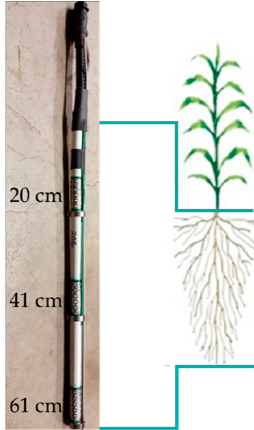
Figure 5. Node of three watermark soil moisture sensors located at depths of 20 cm, 41 cm, and 61 cm.